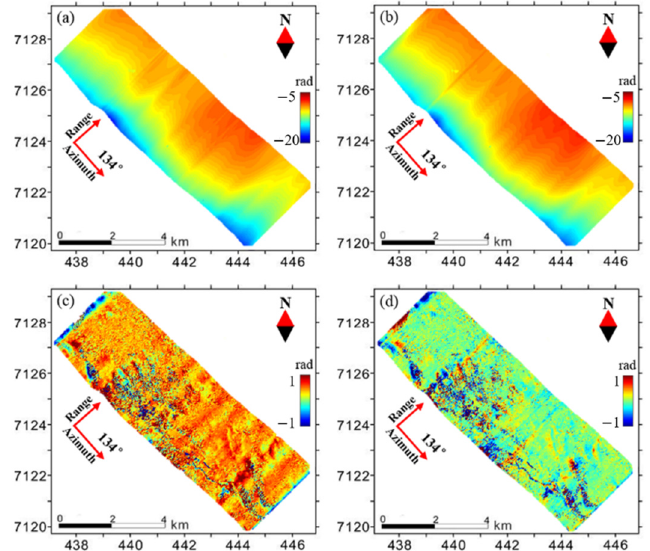
Figure 7. Correction of the RME-induced phase errors. ( a , b ) are the RME-induced phase maps of the first and fifth sublook coherences, respectively. ( c , d ) show the difference maps between the first and the fifth sublook phases (i.e., ϕ 5 − ϕ 1 ) before and after removing the RME-induced phase errors,